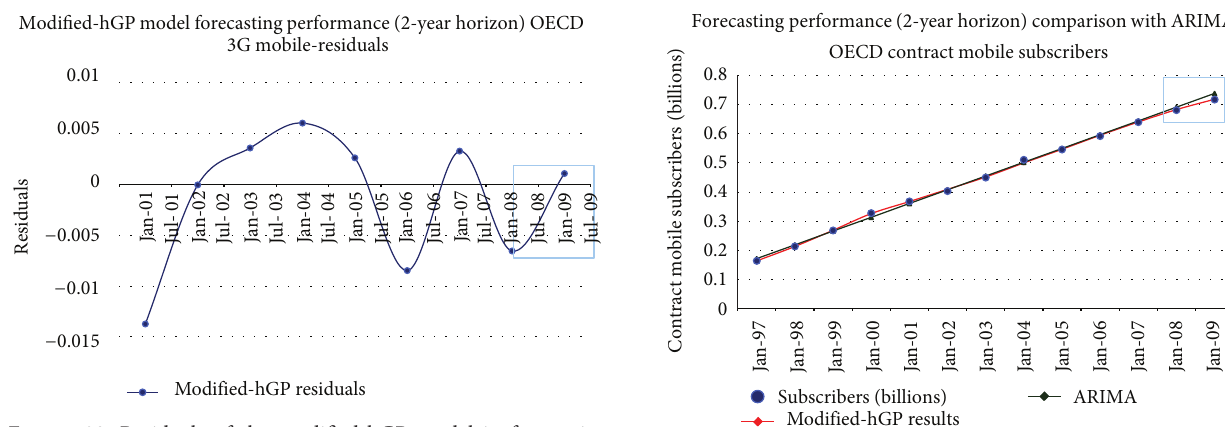
Figure 30: Residuals of the modified-hGP model in forecasting (2 years window period) of the number of OECD mobile 3G subscribers.